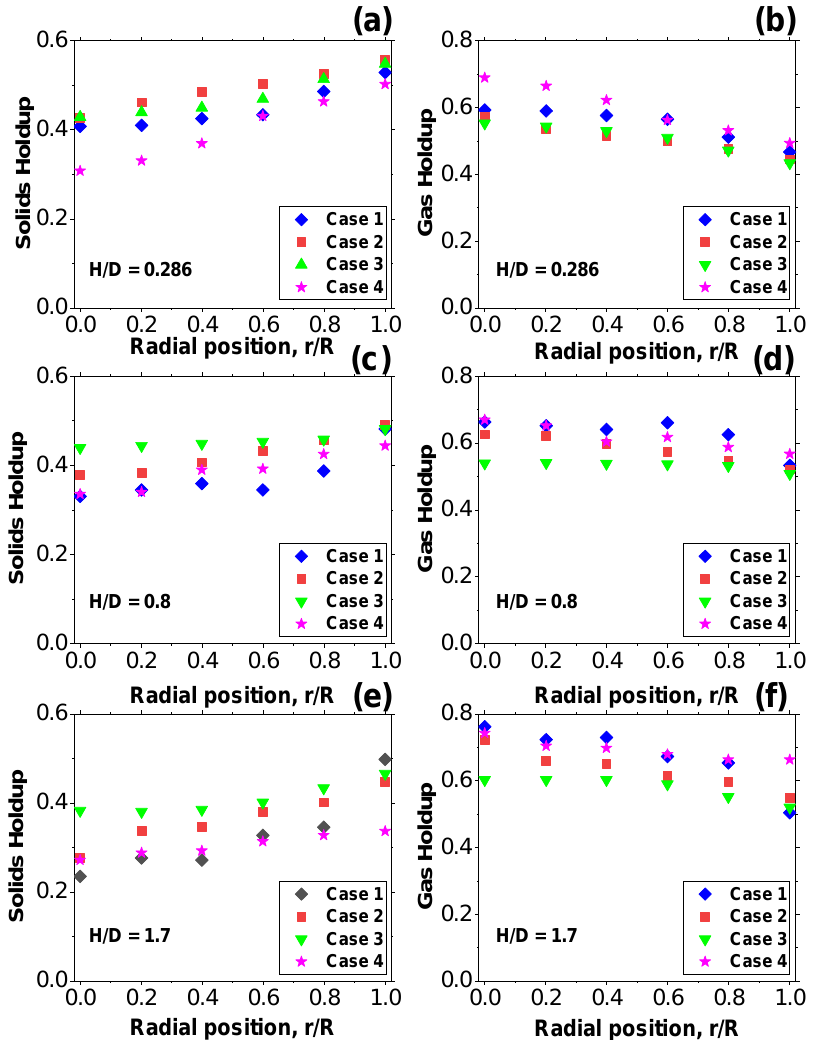
Figure 11. Solids ( a , c , e ) and Gas ( b , d , f ) Holdup as a Function of Radial Position at Different Height Above the Distributor. The Conditions are Given in Table 1. where Case 2 are matching dimensionless groups, and Cases 3 and 4 are mismatching.